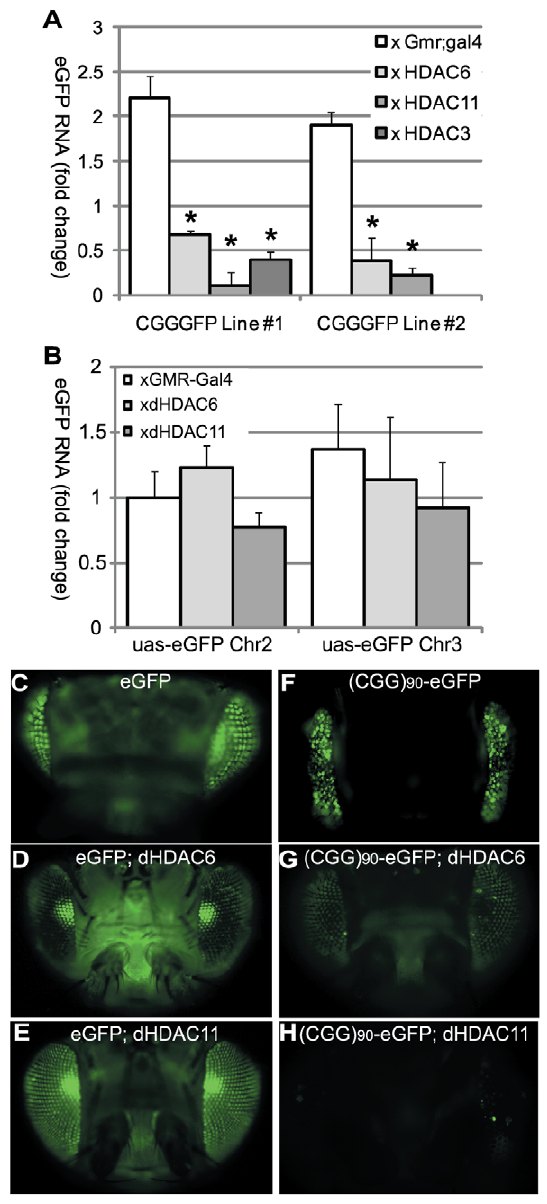
Figure 3. HDAC over-expression suppresses the accumulation of (CGG) 90 -eGFP mRNA. A) RT-PCR performed on total RNA isolated from the heads of flies with the noted genotypes. eGFP mRNA expression was normalized to18S RNA and expressed as fold change compared to uas-eGFP (Chr2) x gmr-Gal4 alone. (CGG) 90 -eGFP transcript levels for both line 1 and line 2 are significantly decreased when any of 3 classes of HDACs is co-expressed, compared to either line of (CGG) 90 - eGFP crossed with the gmr-Gal4 driver line alone. B) In contrast, there are no significant changes in eGFP mRNA levels when HDAC6 or HDAC11 is co-expressed with either of 2 uas–eGFP lines with different chromosomal insertion sites. Data represent the summary of 3 independent experiments with n . 10 for each genotype. (C–H) eGFP protein expression in fly lines was visualized by fluorescence. Co- expression of HDAC6 (D) or HDAC11 (E) with eGFP leads to little or no decrease in fluorescent signal. In contrast, eGFP protein expression in (CGG) 90 -eGFP flies (F) is markedly reduced by co-expression of HDAC6 (G) or HDAC11 (H). *=P , 0.01 versus (CGG) 90 -eGFP alone by a Students unpaired t-test.